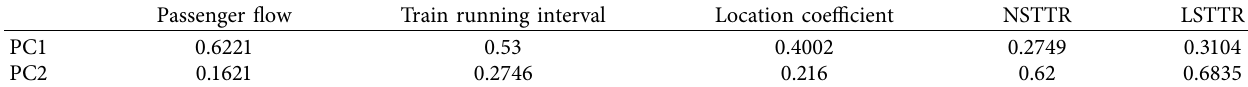
Table 6: Principal component matrix of clustering elements processing.